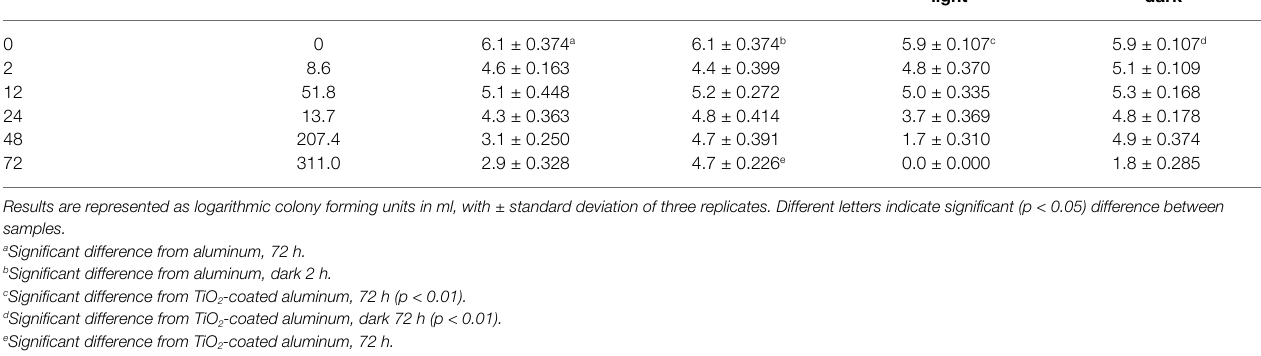
TABLE 2 | Number of L. monocytogenes on aluminum plates after 0–72-h 405 nm light illumination at +5 ± 2 ° C. Illumination 405 nm